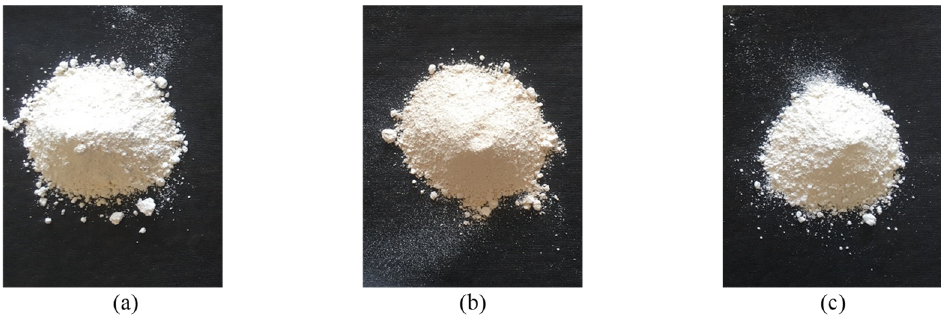
Figure 1. Sample of metakaolin products ( a ) MK1; ( b ) MK2; ( c ) MK3.